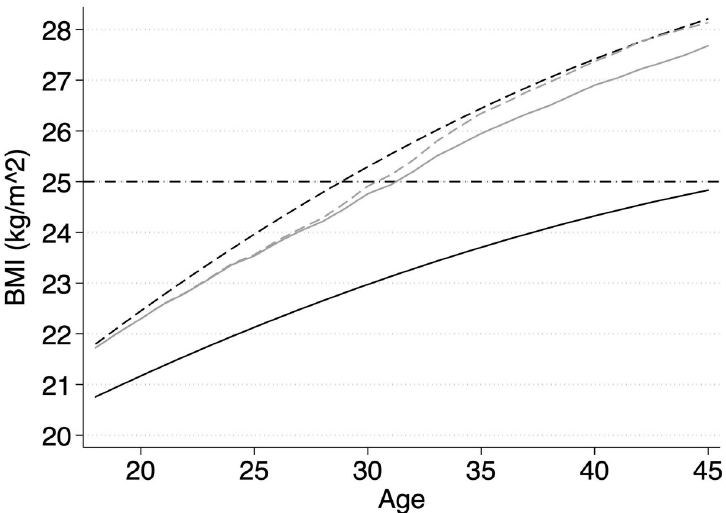
Fig 5. Predicted Body Mass Index (BMI) for lower and higher educated women with and without adjustment for motherhood. SOEP data, v.34; own calculations; height is fixed at the average of 167 cm in both models; black solid reference line = body weight of higher educated women, black dashed line = difference in body weight between lower educated women and higher educated women based on model M1, Table 2; grey dashed line = difference in body weight between lower educated women and higher educated women adjusted for differences in prevalence of motherhood; grey solid line = difference in body weight between lower educated women and higher educated women adjusted for differences in prevalence and effects of motherhood (M3), Table 2. The dotted horizontal line at 25 indicates the threshold to overweight according to the WHO definition.